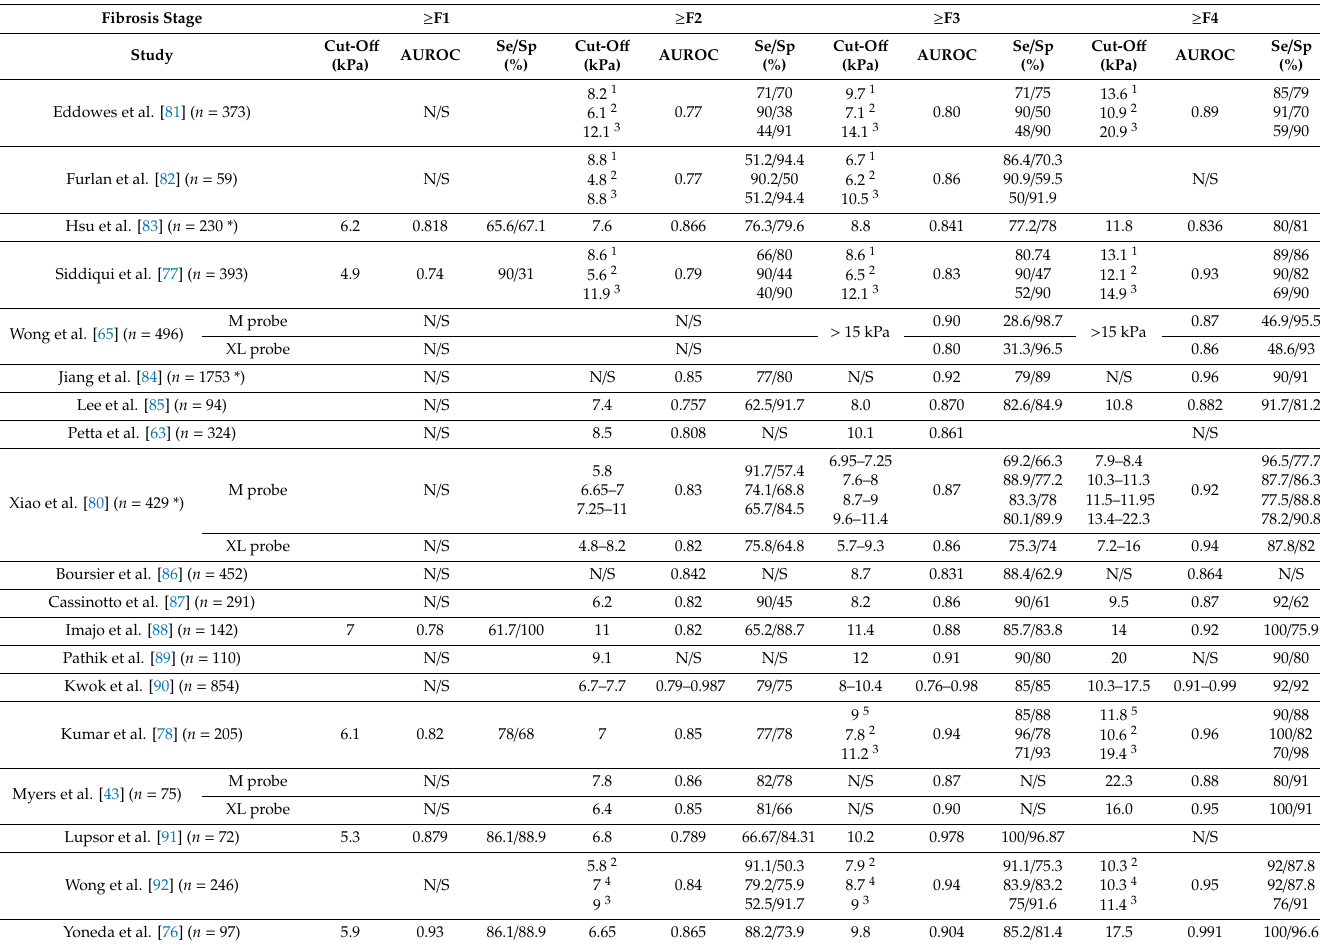
Table 2. Performance of liver sti ff ness (LS) cut-o ff values by VCTE for detecting di ff erent stages of liver fibrosis in NAFLD